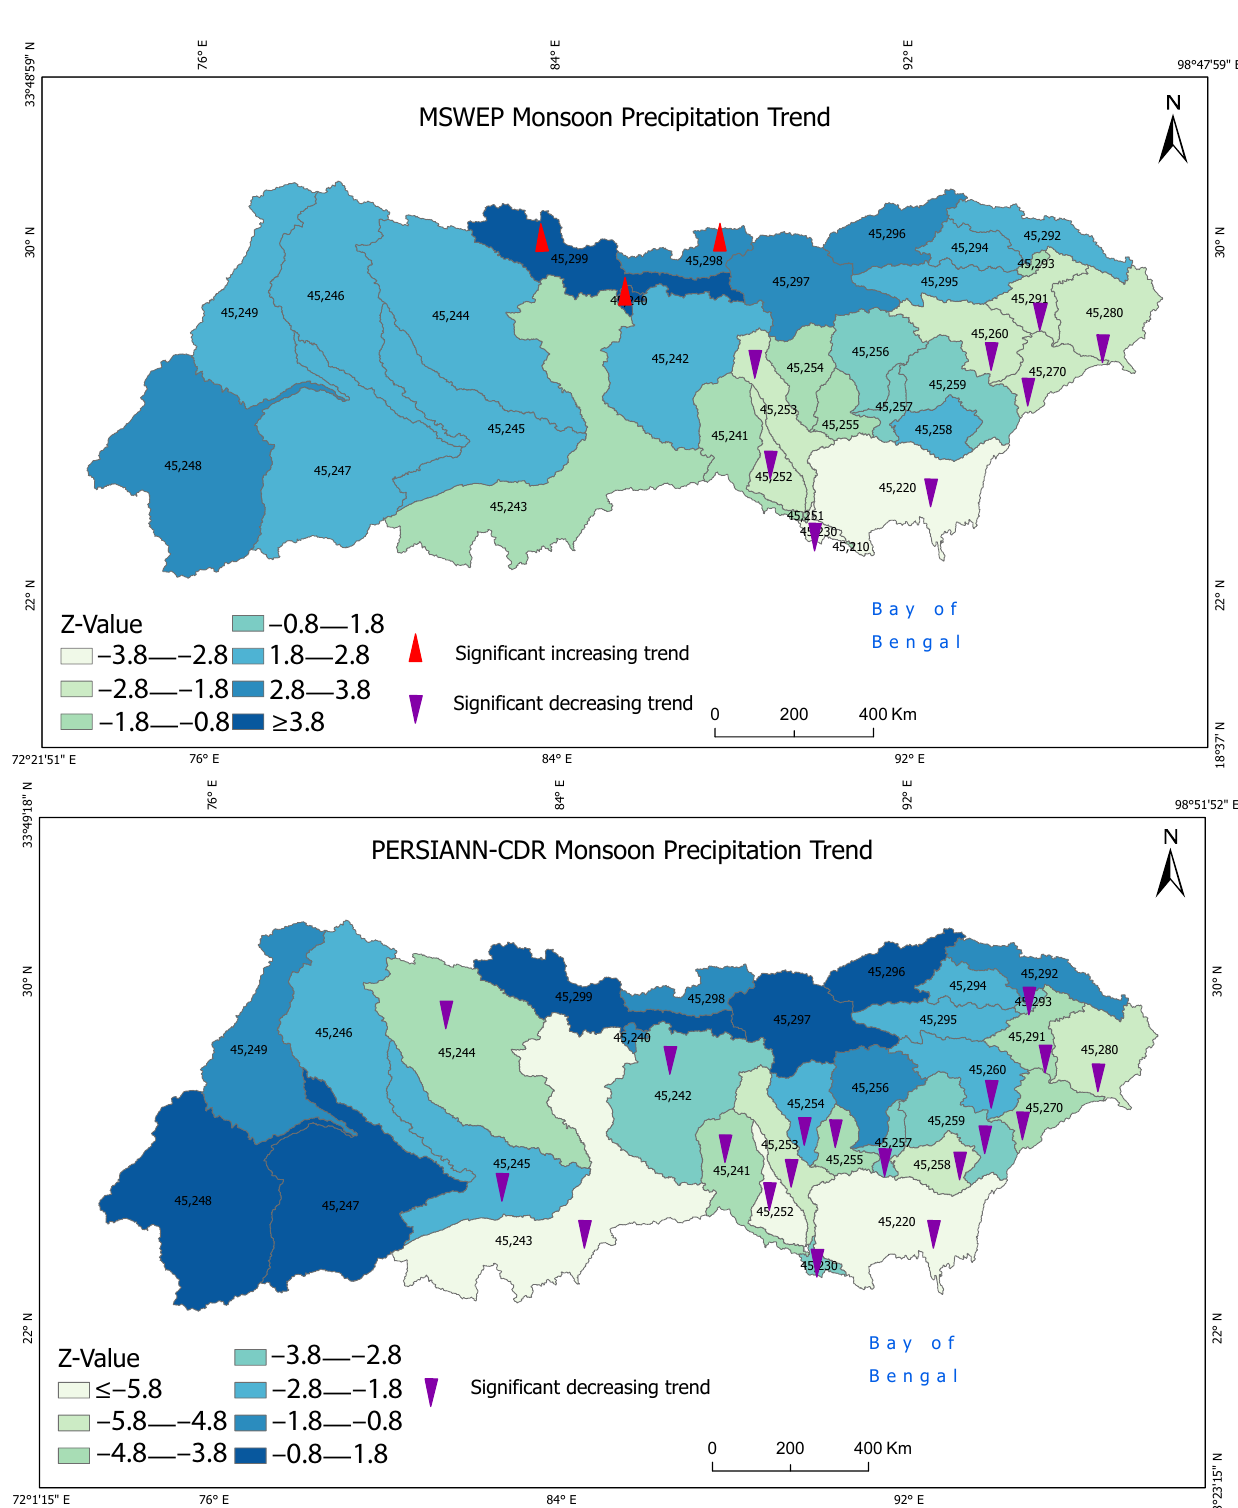
Figure 6. Monsoon precipitation trend for ( a ) MSWEP and ( b ) PERSIANN-CDR. Red color upright triangle indicates a significant increasing trend ( p < 0.05), and a purple color downright triangle indicates significant decreasing